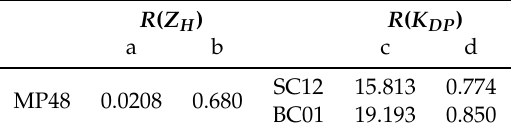
Table 1. Parameters of R ( Z H ) and R ( K DP ) power law relations for the CHUVA X-band Radar. R ( Z H ) R ( K DP ) a b c d